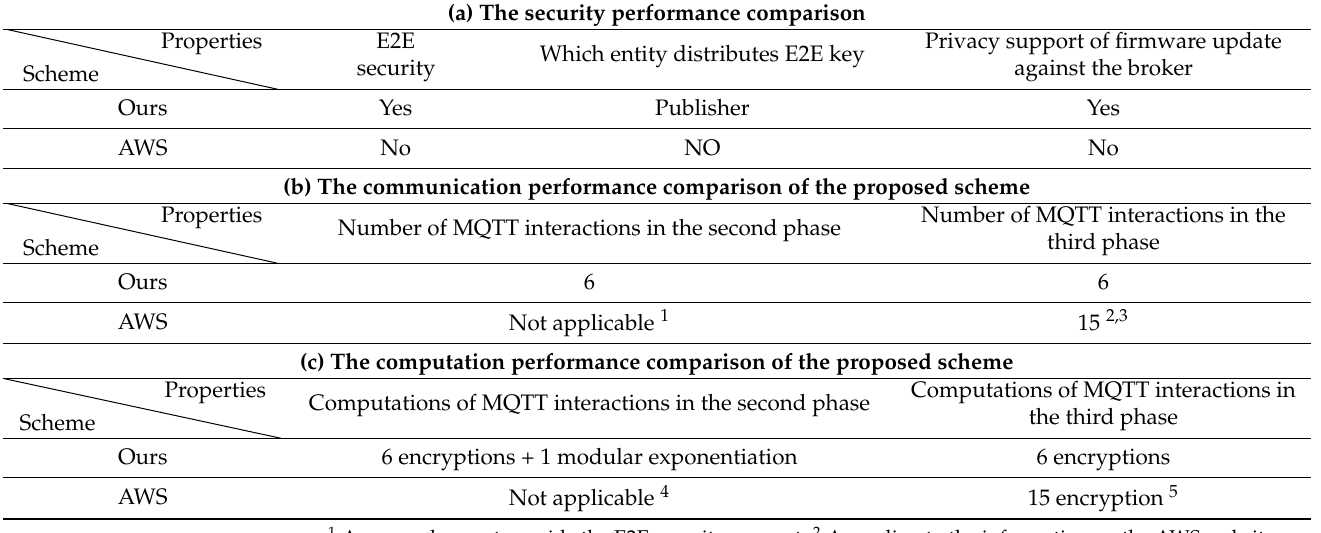
Table 3. The performance comparison. (a) The security performance